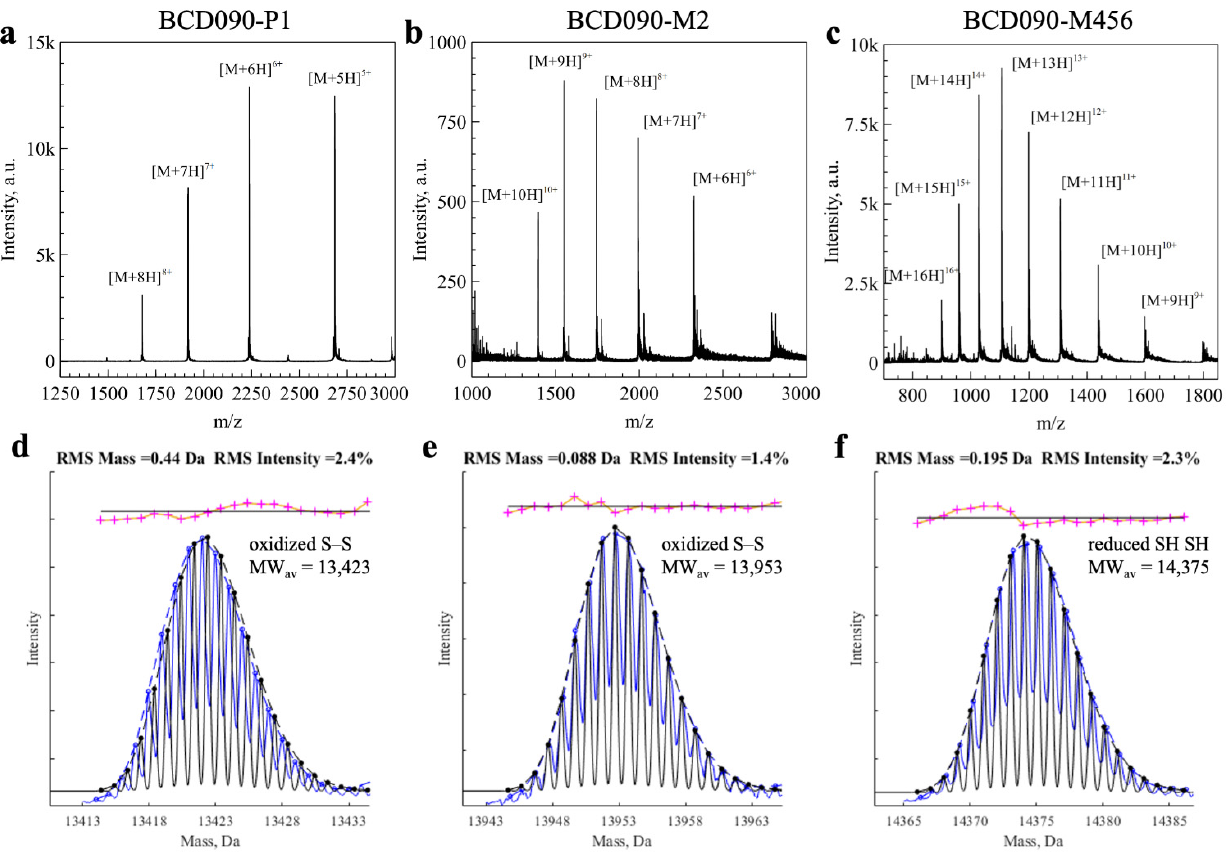
Figure 3. Analysis of the single-domain antibodies by ESI-MS. ( a – c ) Experimental mass spectra with individual charge states indicated; ( d – f ) experimental isotopic distribution after charge deconvolution (blue) fitted with theoretical isotopic distribution (black). For BCD090-P1 and BCD090-M2, best fit obtained with the formula corresponding to oxidized cysteines (-2H) as expected. On the contrary, experimental data for BCD090-M456 were best fitted with formula with free cysteines.